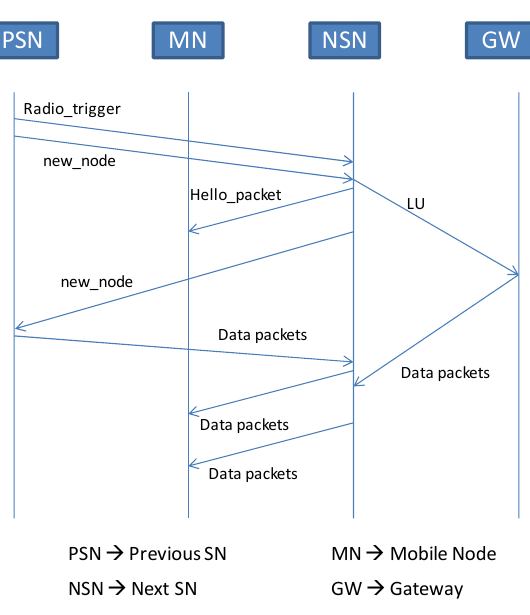
Figure 4. MN’s handoff support